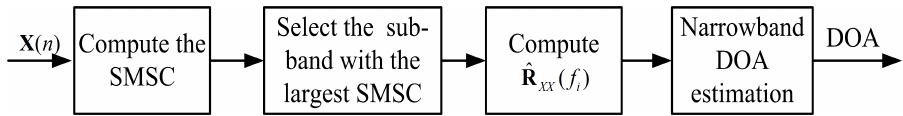
Figure 4. The flow chart of the sub-band direction-of-arrival (DOA) estimation